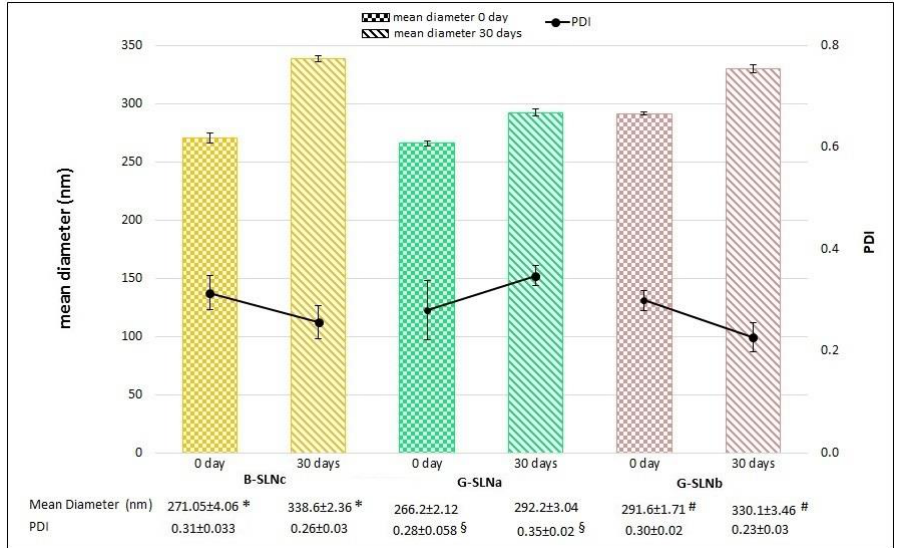
Figure 2. Physical stability of unloaded and GEN-loaded SLN after 30 days. p < 0.05: *B-SLNc at 0 days vs B-SLNc at 30 days; # G-SLNb at 0 days vs G-SLNb at 30 days; § G-SLNa at 0 days vs G-SLNa at 30